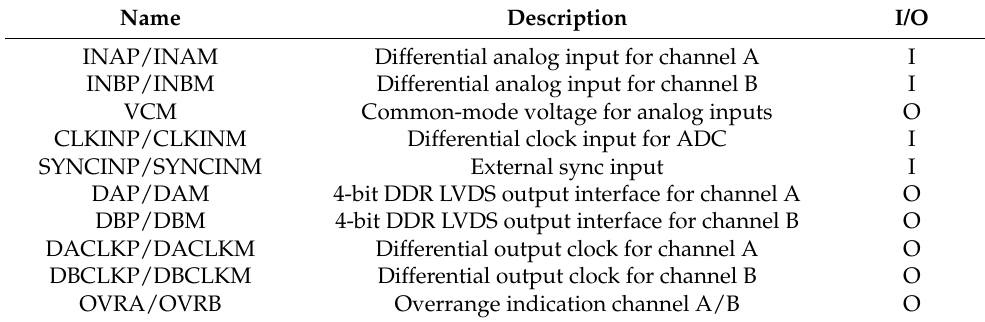
Figure 4. The simplified schematic of ADS42LB69. Table 1. Parts of Pin functions of the ADS42LB69.